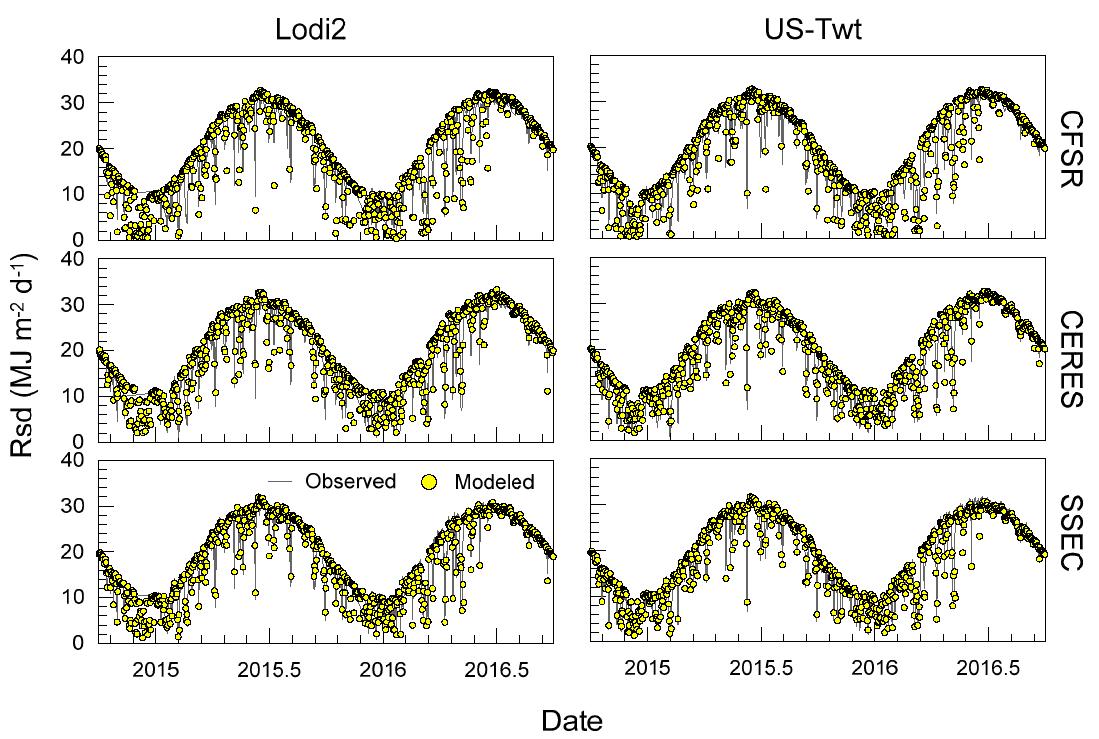
Figure 6. Daily modeled and observed insolation timeseries at the Lodi2 and US-Twt flux sites.